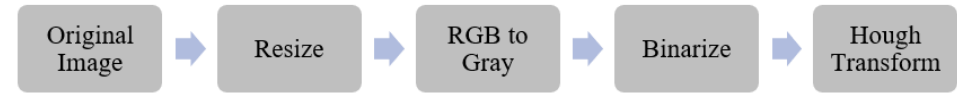
Figure 5. Image processing sequence.